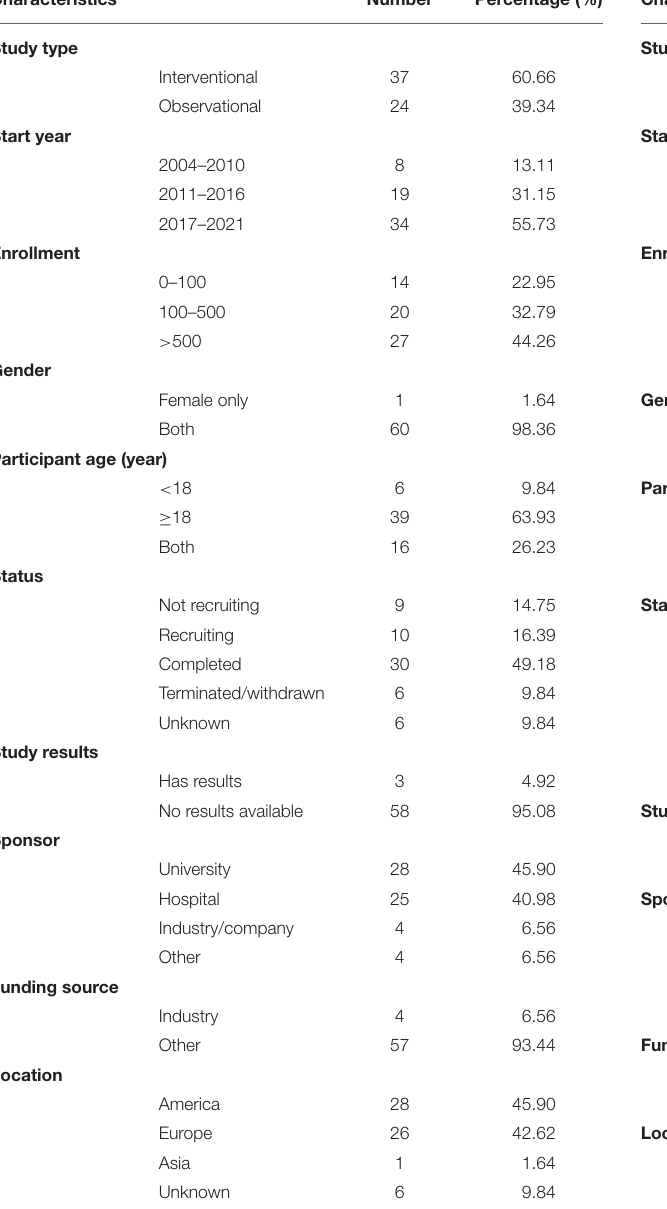
TABLE 5 | The characteristics of the 85 trials in ICU registered on ClinicalTrial.gov.